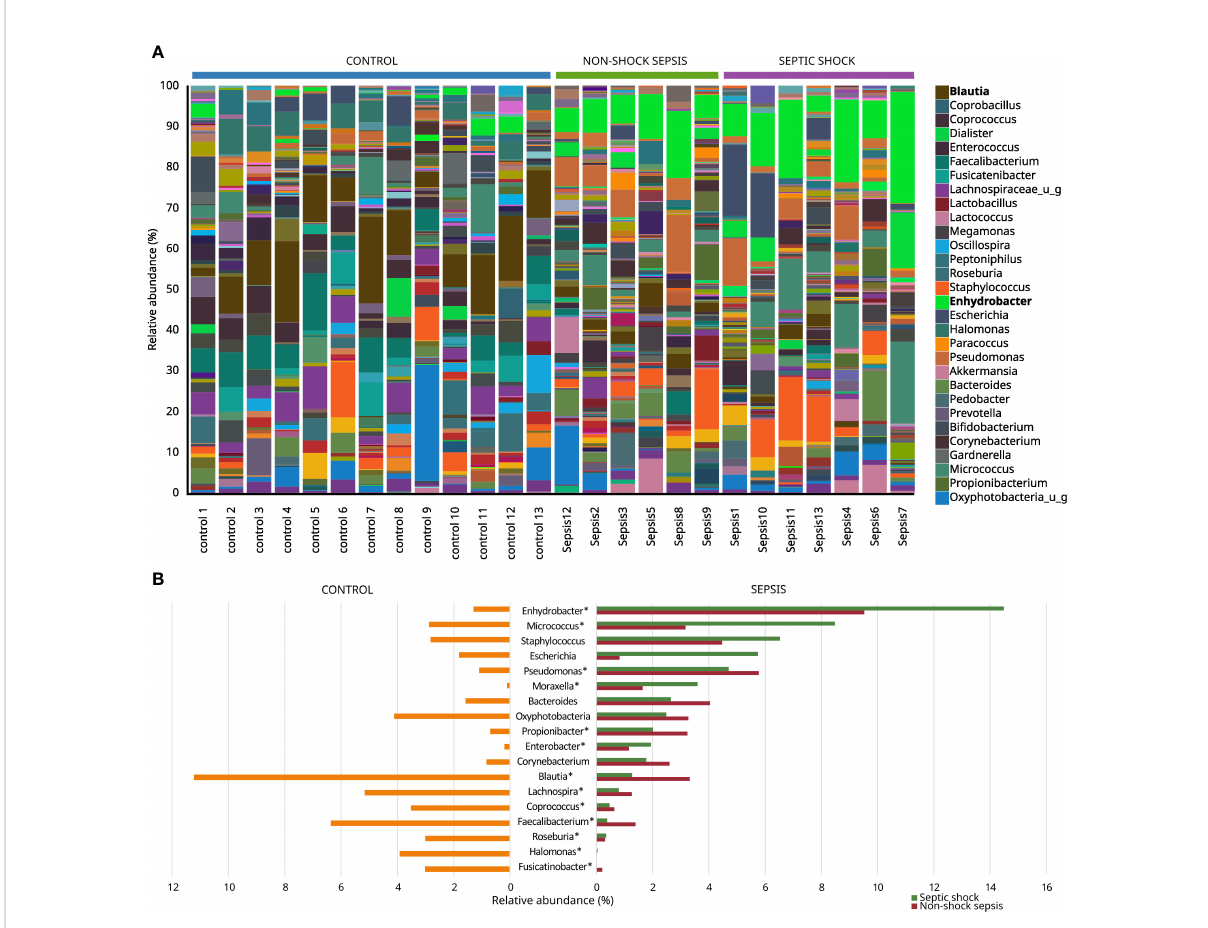
FIGURE 4 Most abundant genera among non-septic control, non-shock sepsis and septic shock patients (A) , and genera with the highest overall relative abundance among non-septic control and septic patients (B) . * means signi fi cant